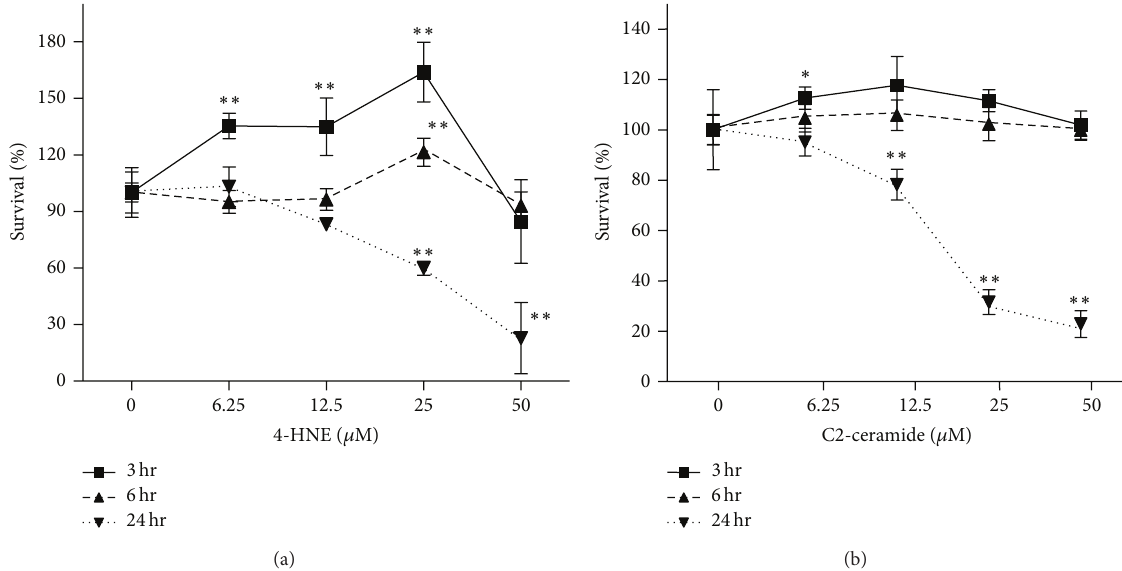
Figure 1: Kinetics of cell death under oxidative stress. Uninfected ARPE cells were exposed to 4-HNE or C2-ceramide. Cell survival was measured by MTS assay after 3, 6, or 24 hours of exposure. Cells not exposed to the stressors served as controls. Data represent the mean ± standard deviation (SD) ( 𝑛 = 5 , ∗ 𝑃 < 0.05 ; ∗∗ 𝑃 < 0.01 ; unpaired t